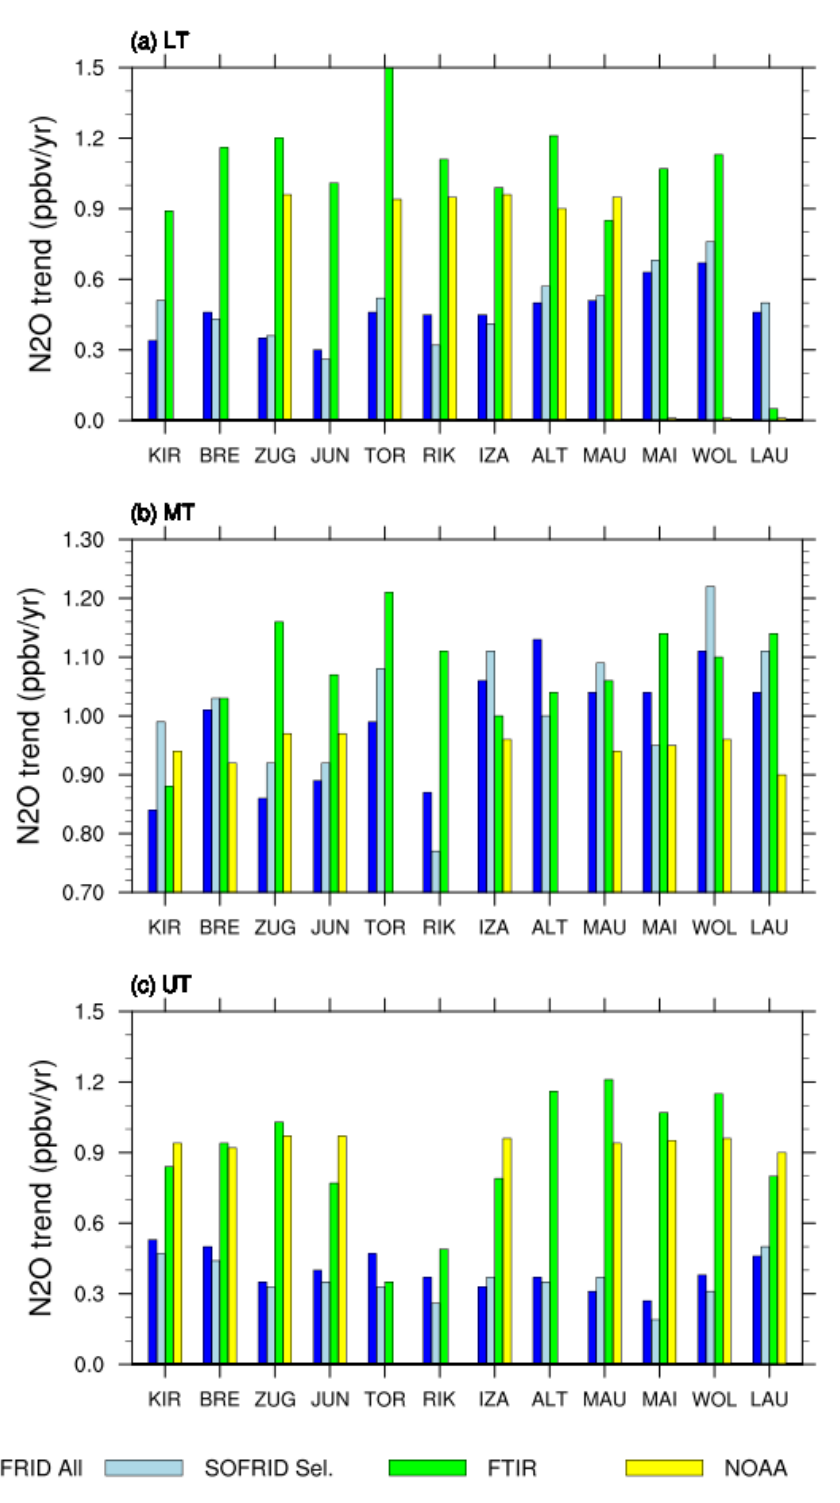
Figure 9. Decadal trends from SOFRID and FTIR monthly N 2 O VMRs in the ( a ) LT ( b ) MT and ( c ) UT for the 12 NDACC stations (Table 1). The stations are identified by the three first letters of their names on the x-axis. Trends from surface measurements at coincident NOAA-ESRL stations (Table 5) are also displayed for